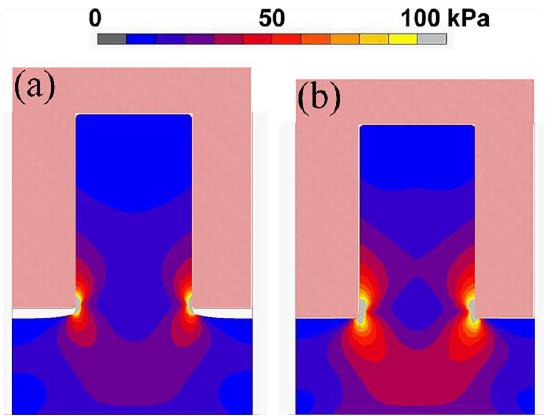
Figure 3. Finite element simulations showing von Mises stress distribution at the moment of demolding. The Young’s modulus values of the polymethylmethacrylate (PMMA) resists are ( a ) 0.5 and ( b ) 5 MPa. The magnitude of the applied detachment force is the same for both resists. Reprinted with permission from [53]. Copyright 2014 American Vacuum Society.